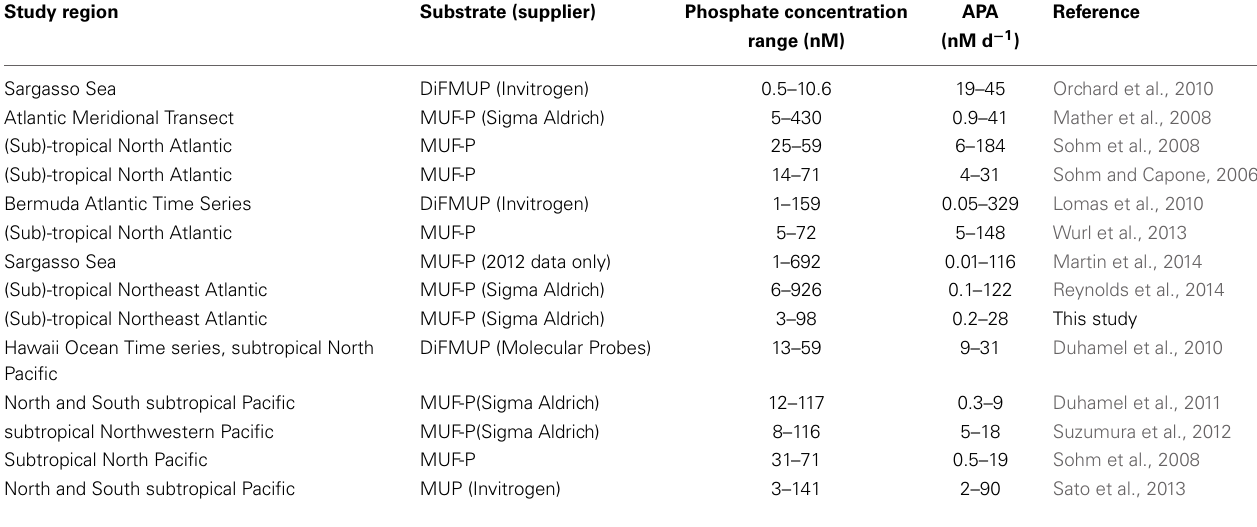
Table 1 | Summary of location, range in phosphate concentration (nM) and rates of alkaline phosphatase activity (APA, nM d − 1 ) for published studies used in the data synthesis. The substrate (and supplier when reported) used in the study, 4-methylumberlliferyl phosphate (MUF-P), 4-methylumbelliferyl phosphate (MUP) or 6,8-difluoro-4-methylumbelliferyl phosphate (DiFMUP) are